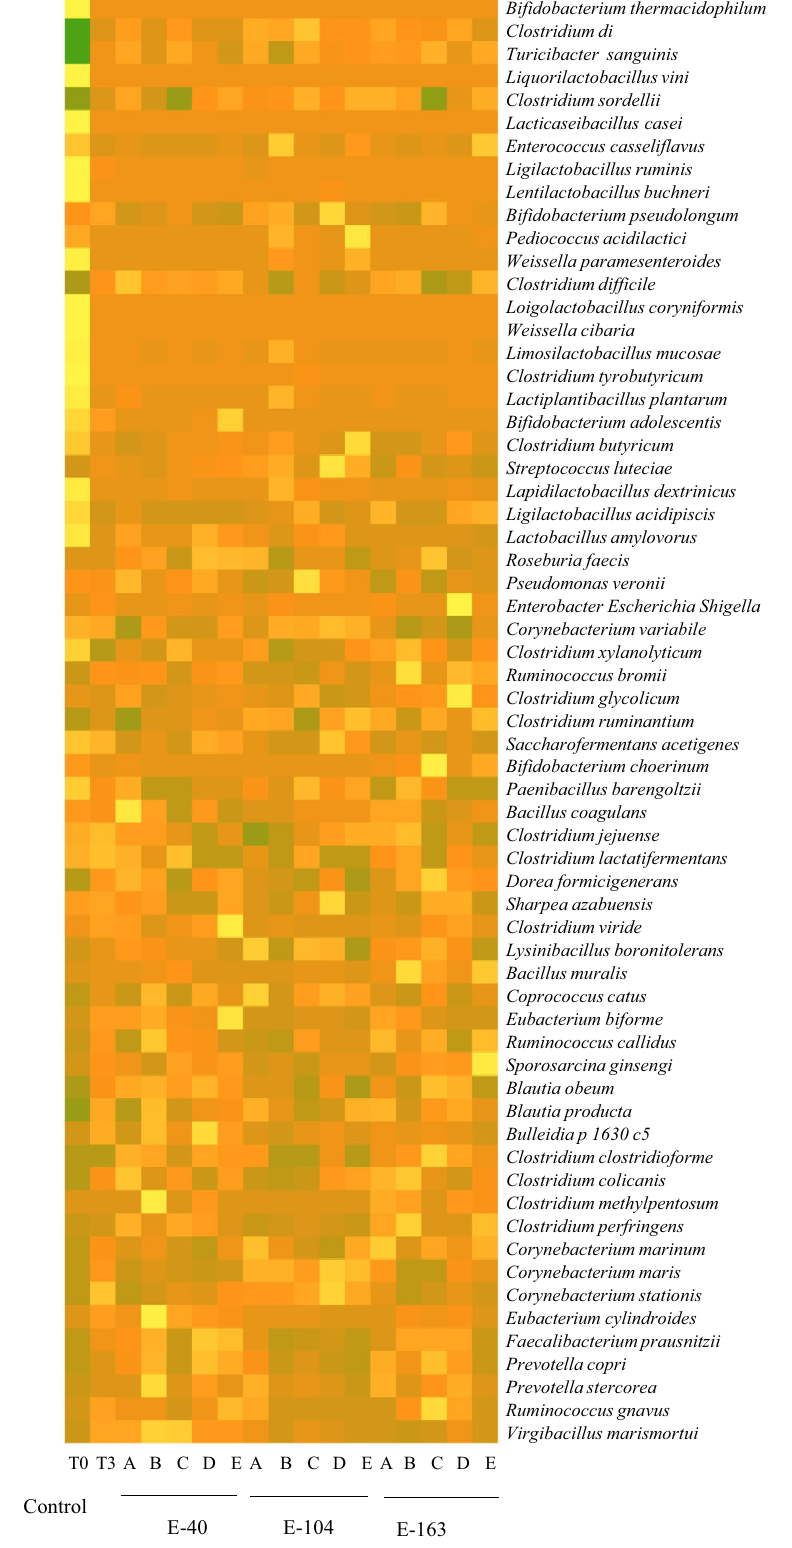
Figure 6. Heatmap showing the species profile in probiotic-treated (A: Lactobacillus acidophilus CRL 2074 ; B: Limosilactobacillus fermentum CRL 2085; C: Limosilactobacillus mucosae CRL 2069 ; D: CRL 2085 + CRL 2069; E: CRL 2074 + CRL 2085 + CRL 2069) and untreated (control) feedlot fecal samples at different experimental administration periods (E-40, E-104 and E-163). For each probiotic group, samples at T3 were considered, while for controls T0 and T3, samples were analyzed. The figure was generated using the heatmap web server http:// www. heatm apper. ca/ expre